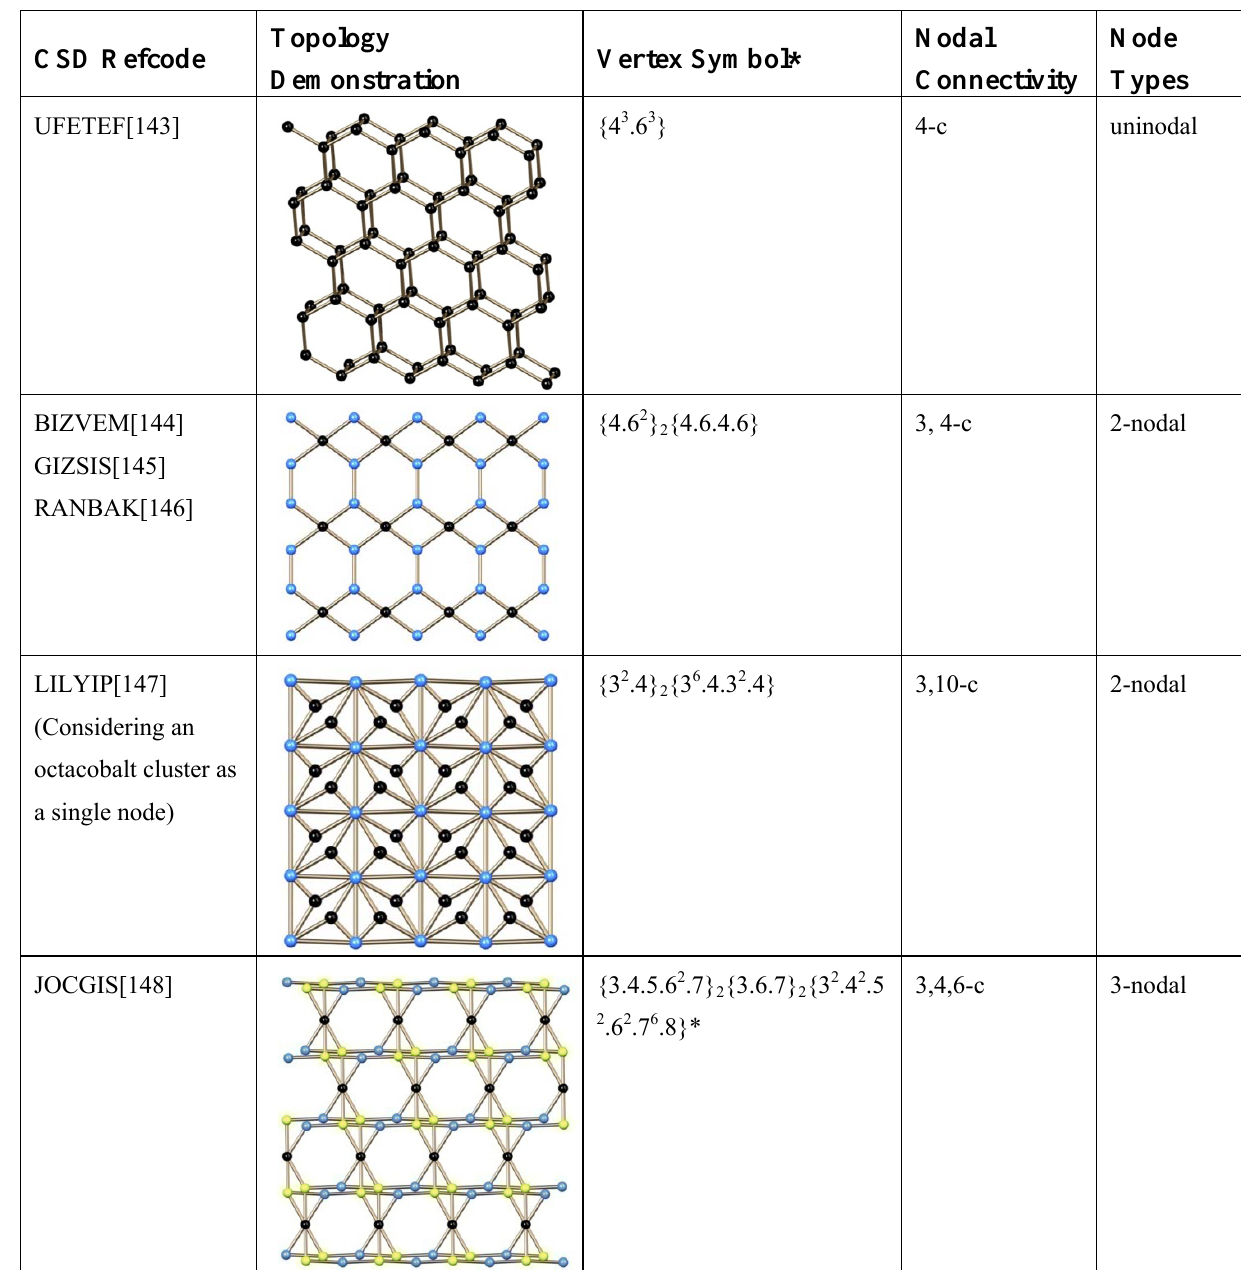
Table 1. New Two-Dimensional